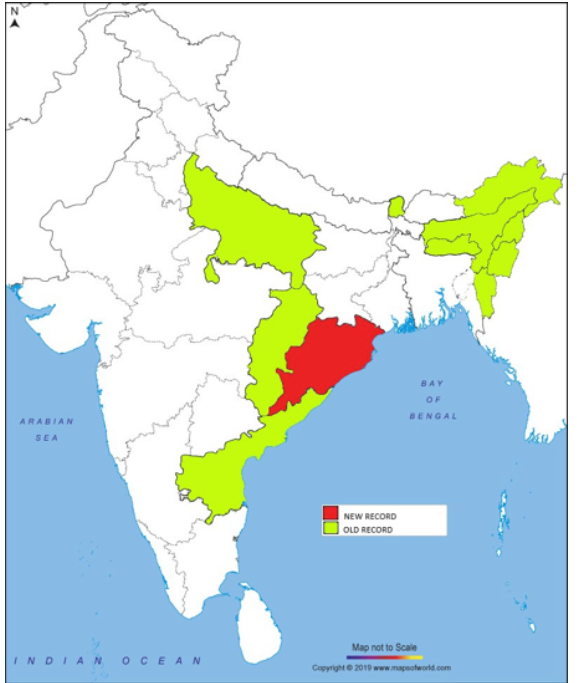
Figure 1. Distribution of Dicranocentroides indica in India showing old and new records.